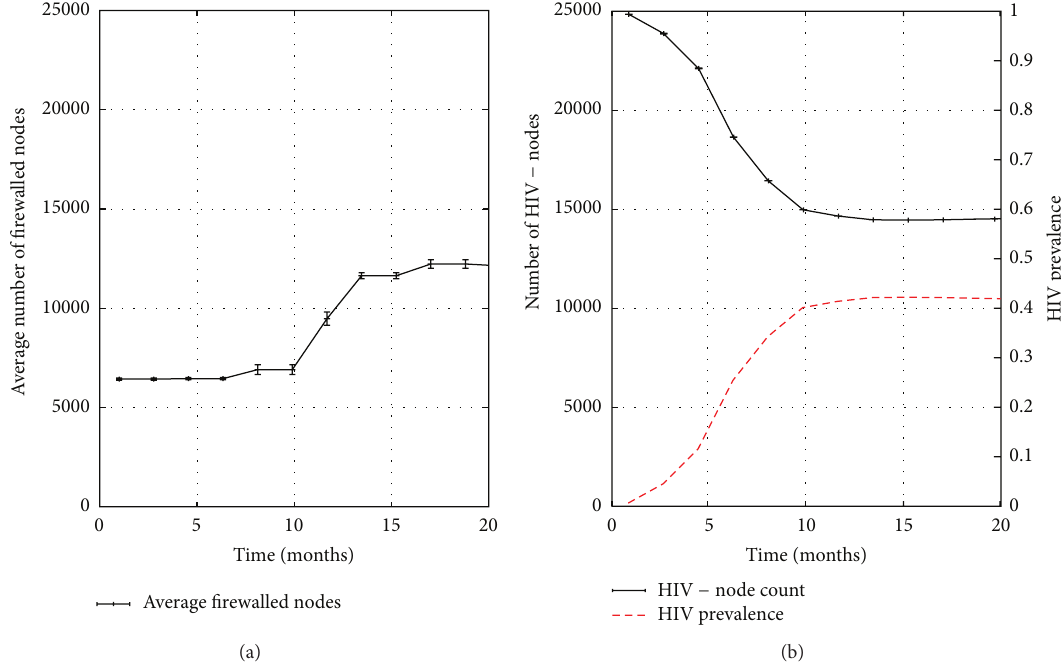
Figure 7: The emergent period: (a) firewalled nodes; (b) HIV prevalence, number of HIV − individuals.